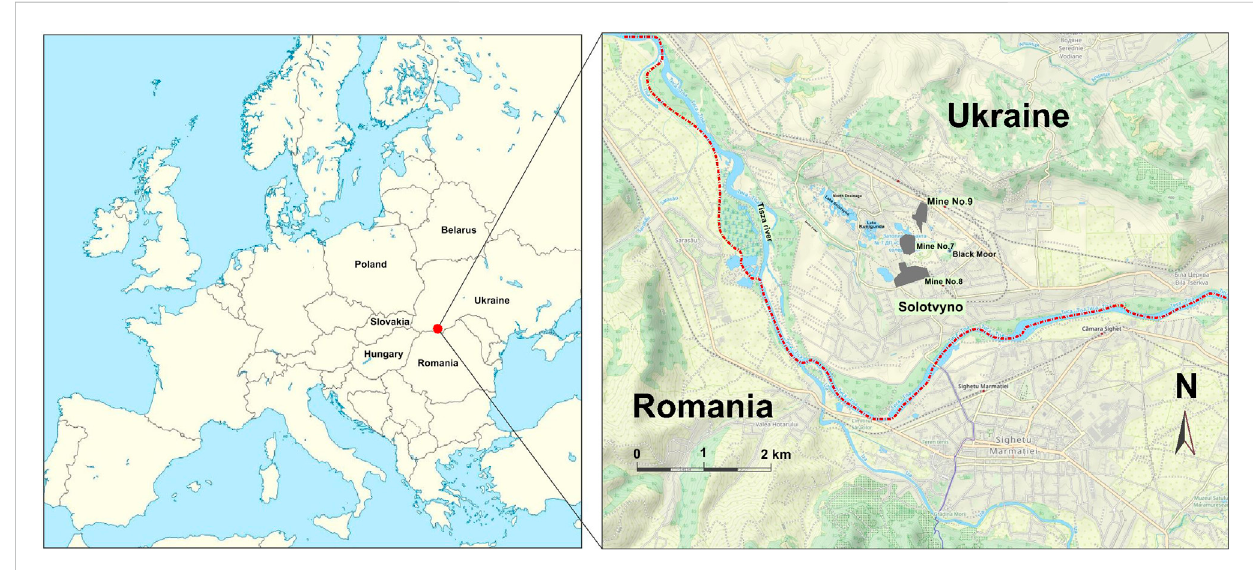
FIGURE 3 Solotvyno region (Source: authors, base maps SAS. Planet v221122.10312 Nightly; Yakovlev et al.,